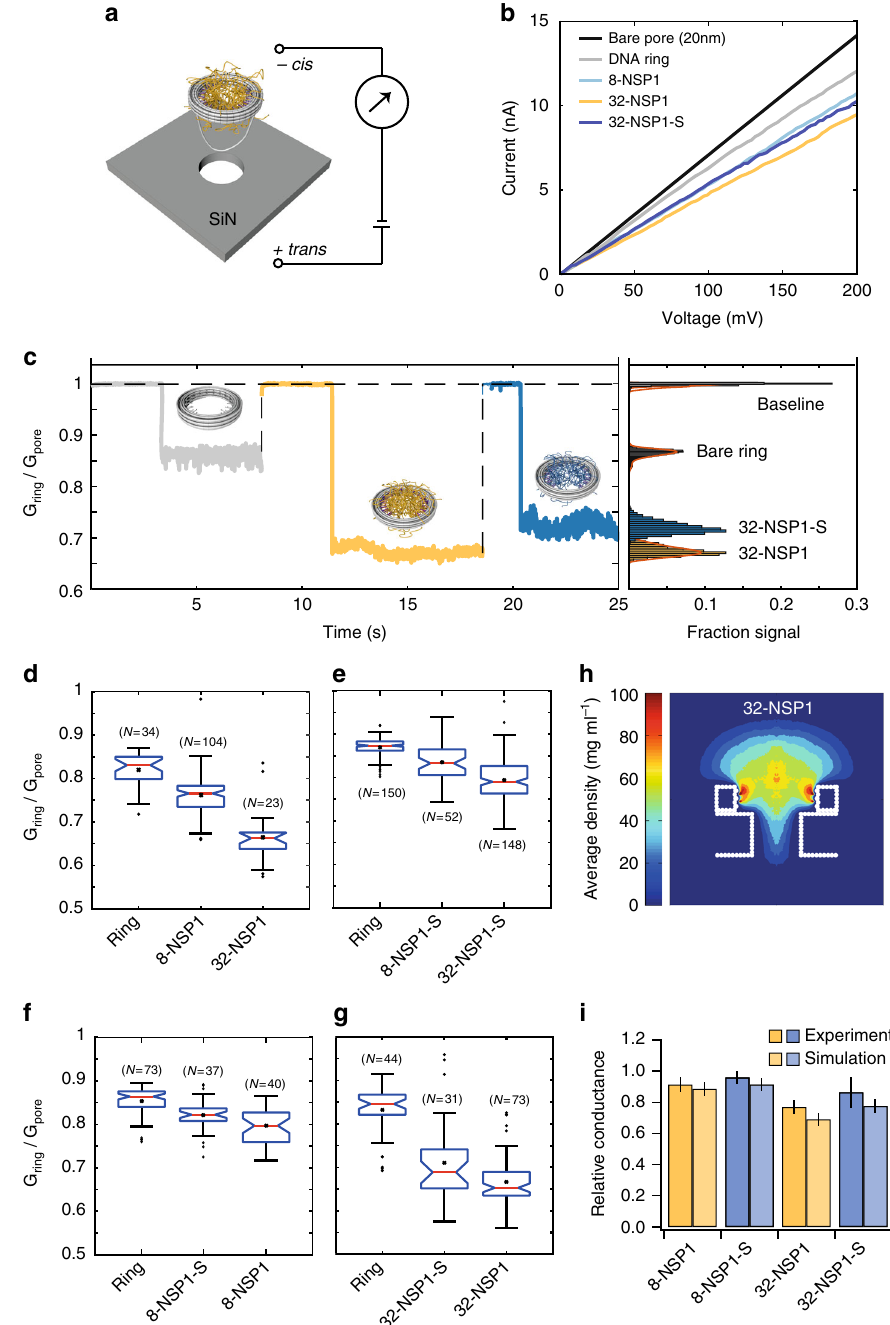
Fig. 4 Ionic conductance of rings with FG-Nups docked on a solid-state nanopore. a Schematic representation of DNA ring that is docking onto a solid-state nanopore. b Exemplary current (nA) versus voltage (mV) traces for rings without proteins, 8-NSP1, 32-NSP1 and 32-NSP1-S and the bare nanopore. c Exemplary relative conductance ( G ring / G pore ) vs time (s) traces showing the change in conductance upon docking of the ring without protein (gray), 32- NSP1 (yellow), and 32-NSP1-S (blue). d Box plot representation of the relative conductance ( G ring / G pore ) for the empty ring, 8-NSP1 and 32-NSP1. e Same as ( d ), but for empty ring, 8-NSP1-S and 32-NSP1-S. f Same as ( d ), but for empty ring, 8-NSP1 and 8-NSP1-S. g Same as ( d ), but for empty ring, 32-NSP1 and 32-NSP1-S. Each of the panels d – g represents a different nanopore experiment where a series of rings are probed on one particular solid-state nanopore. In the box plot representation in d – g , the blue boxes denote the 25th and 75th percentiles and the red lines represent the median values with the associated wedges representing a 95% con fi dence interval for the medians (see methods and Supplementary Table 4). h Side view ( rz plane) average density distribution for 32-NSP1 placed on a 20 nm-wide nanopore in a 20 nm thin SiN membrane (see Supplementary Figure 14 for an exemplary simulation snapshot and Fig. S15 for density distributions of other variants). i Comparison of experimental reduced conductance values and